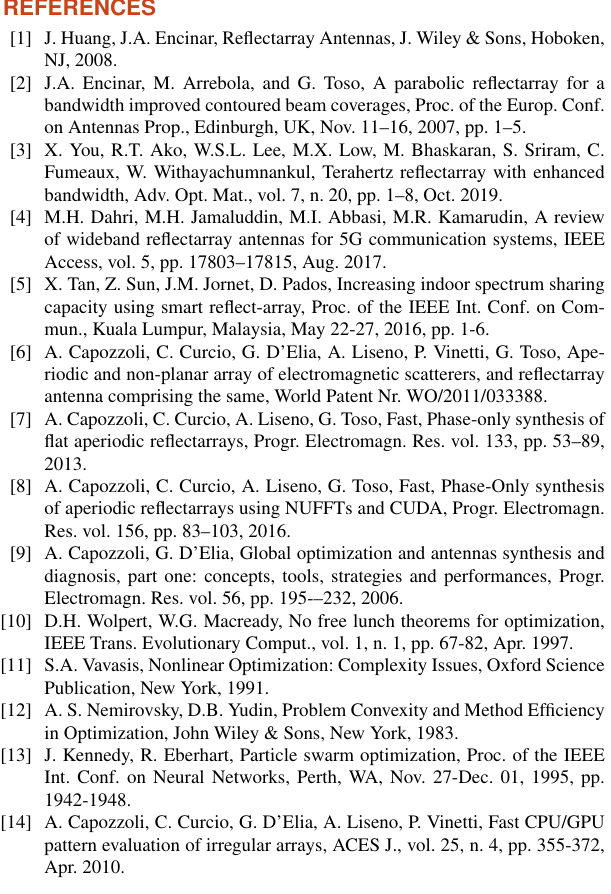
process, i.e., global optimization, as well as of direct radia- tion, the code has run in a convenient time notwithstanding the computational burden of the